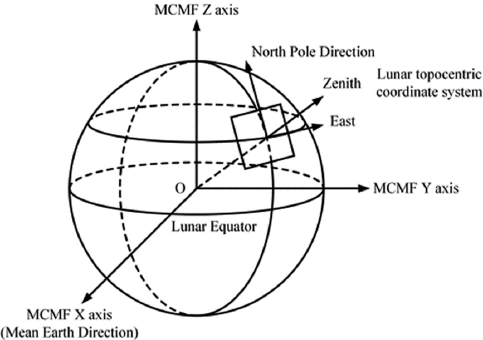
Figure 3. Lunar fixed frame mean Earth/polar axis. Figure Credits [13]. It defines the z-axis as the mean rotational pole. The prime meridian (0 degrees Longitude) is defined by the mean Earth direction. The intersection of the lunar equator and prime meridian occurs at what can be called the Moon’s “mean sub-Earth point”. The concept of a lunar “sub-Earth point” derives from the fact that the Moon’s rotation is tidally locked to the Earth. The actual sub-Earth point on the Moon varies slightly due to orbital eccentricity, inclination, and other factors. So, a “mean sub-Earth point” is used to define the point on the lunar surface where Longitude equals 0 degrees. This point does not coincide with any prominent crater or other lunar surface feature. During these phases, orbital mechanics equations govern the motion. In case of relative navigation, the ground reference system (GRS) is used, depicted in Figure 4.